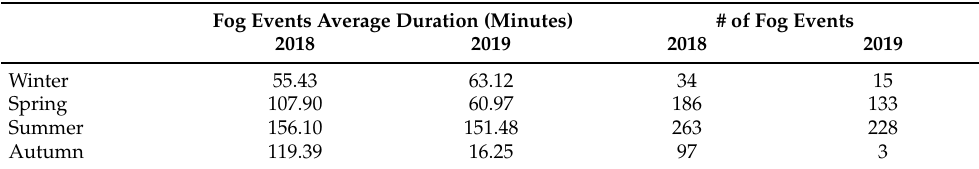
Table 9. Low-visibility events statistics at Mondoñedo station for the years 2018 and 2019, and for the 50 m